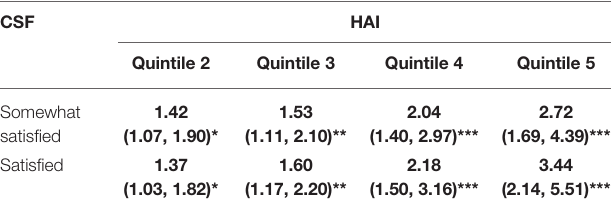
TABLE 3 | Multinomial logistic regression analysis for satisfaction associated with healthy aging in parents aged 45 and older [RRR (95% CI )].